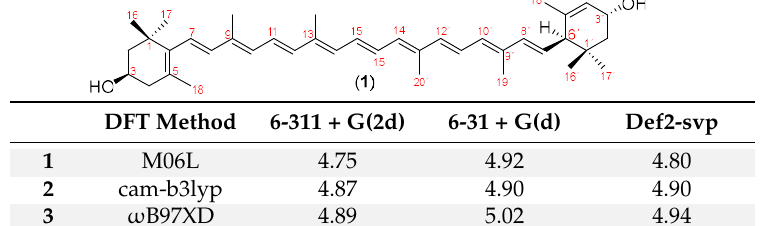
Table 3. p K a values of H-6  in (3 R ,3´ R, 6´ R )-lutein ( 1 ) calculated with different functionals and basis sets.